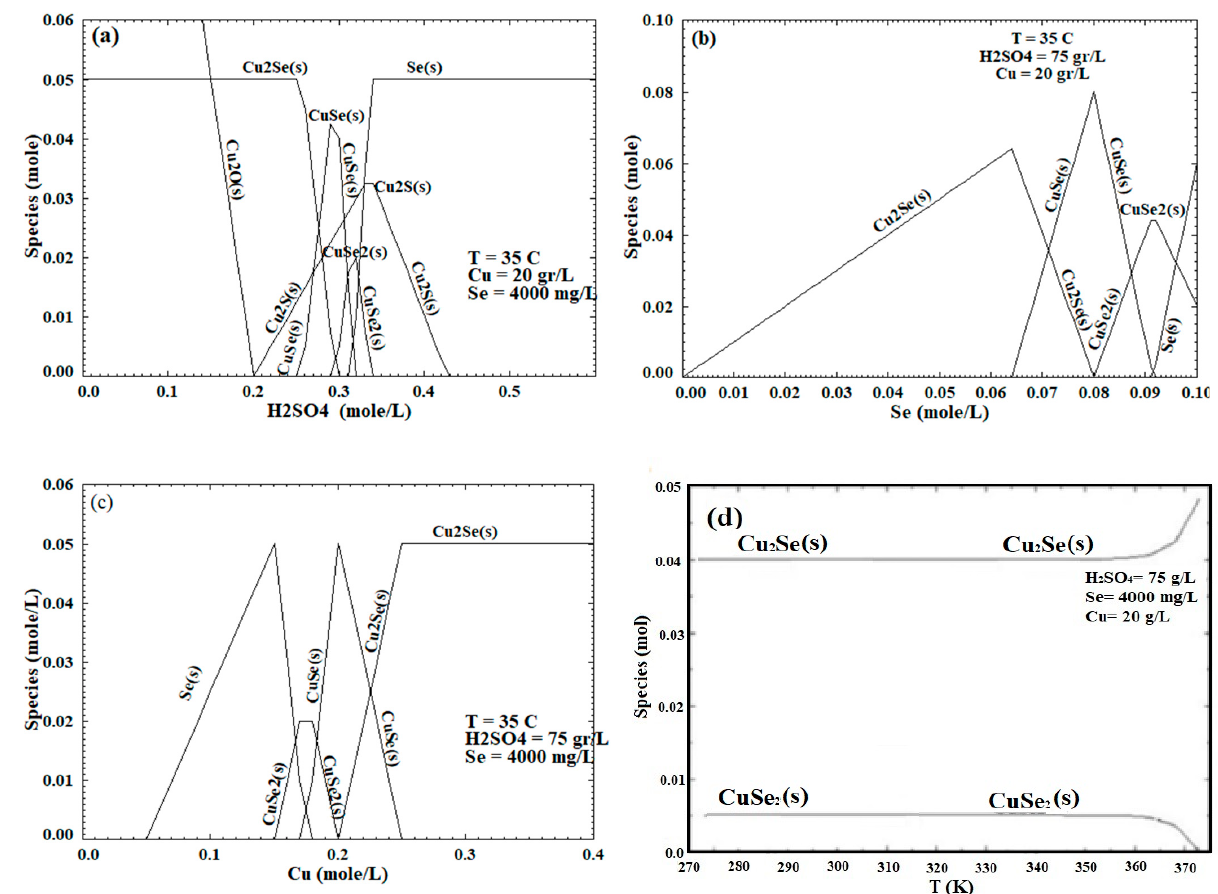
Figure 2. Se species in different ( a ) H 2 SO 4 ; ( b ) Se concentration; ( c ) solid copper values; ( d ) temperature at mean quantity of other factors.